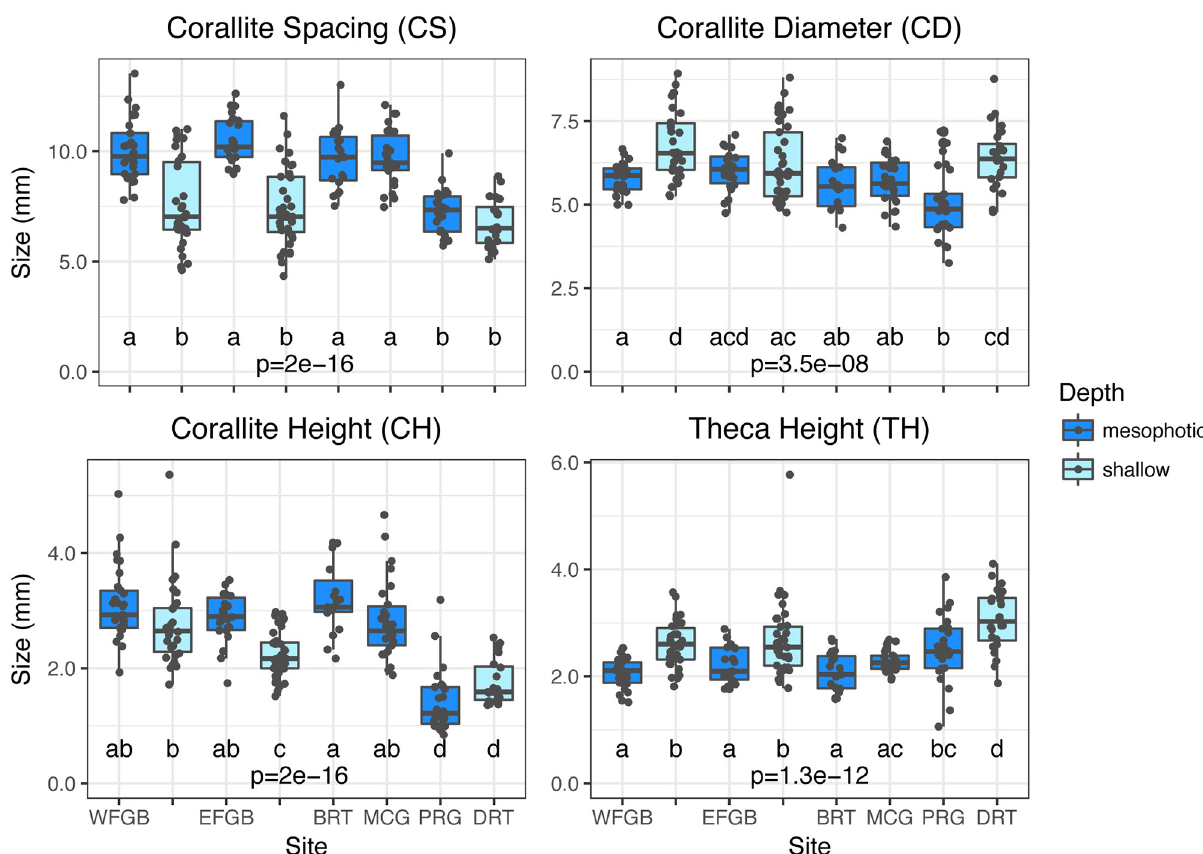
Fig 2. Corallite sample means. Boxplots with sample overlays for corallite spacing (CS), corallite diameter (CD), corallite height (CH), and theca height (TH) across six sites and two depth zones in the Gulf of Mexico. Overall p values represent Kruskal-Wallis tests across sites and depth zones for each metric and different letters denote significant differences ( p < 0.05) between pairwise comparisons of sites and depth zones generated by Dunn’s